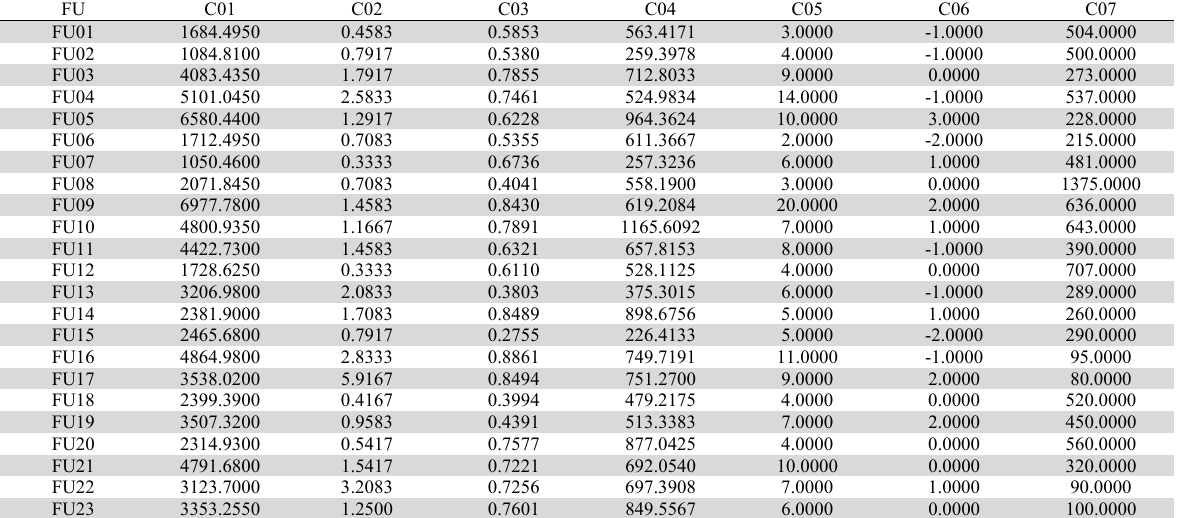
solving the model represented by Eq.